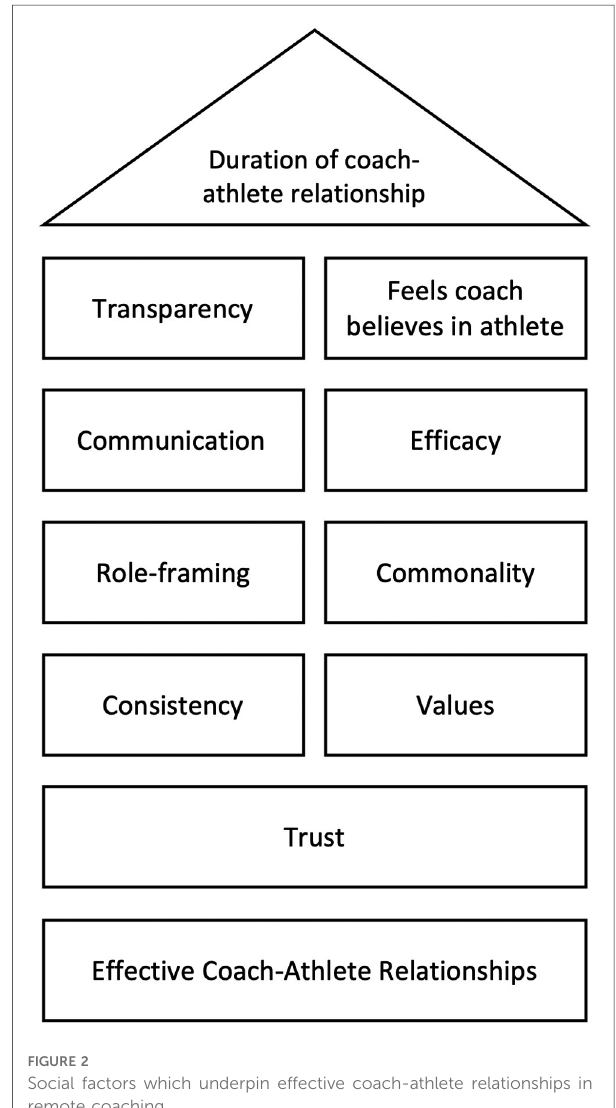
FIGURE 2 Social factors which underpin effective coach-athlete relationships in remote coaching.